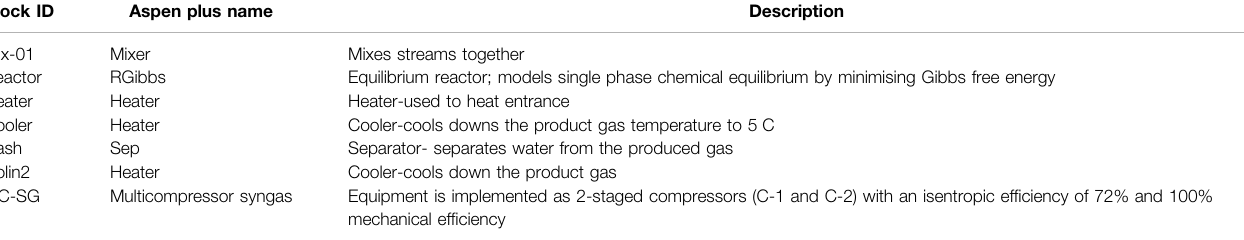
TABLE 1 | Blocks description used in the thermodynamic simulation (Adelung et al., 2021). Block ID